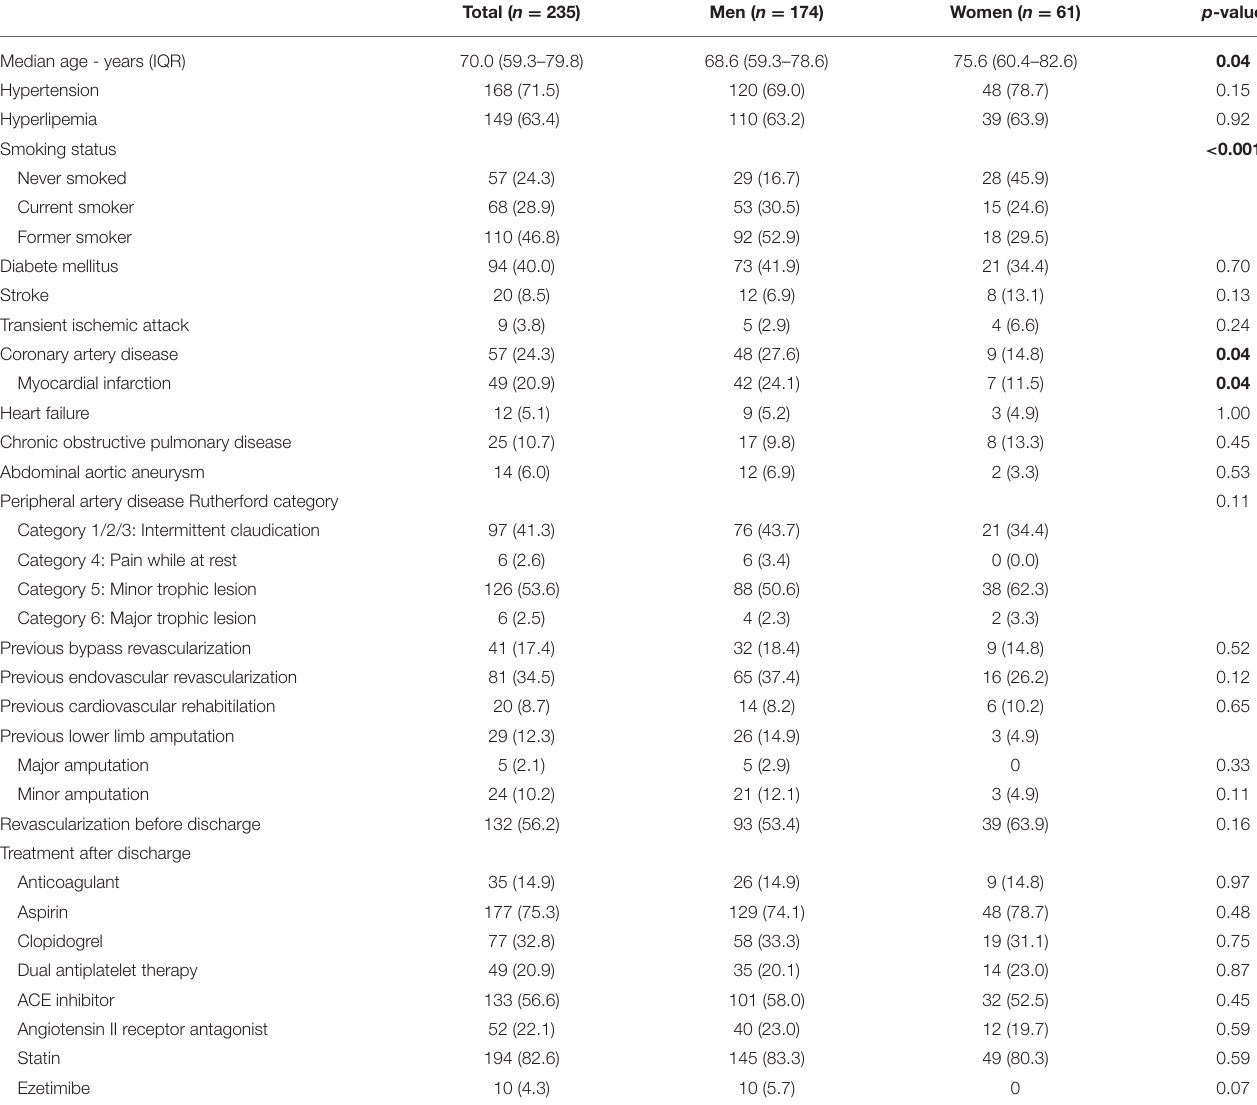
TABLE 1 | Baseline characteristics and sex comparison. Total ( n = 235) Men ( n = 174) Women ( n = 61) p